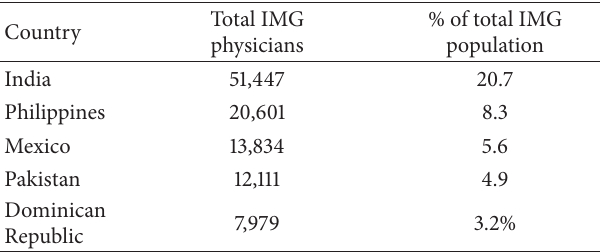
Table 11: Top 5 countries for international medical graduates (IMG) physicians working in the United